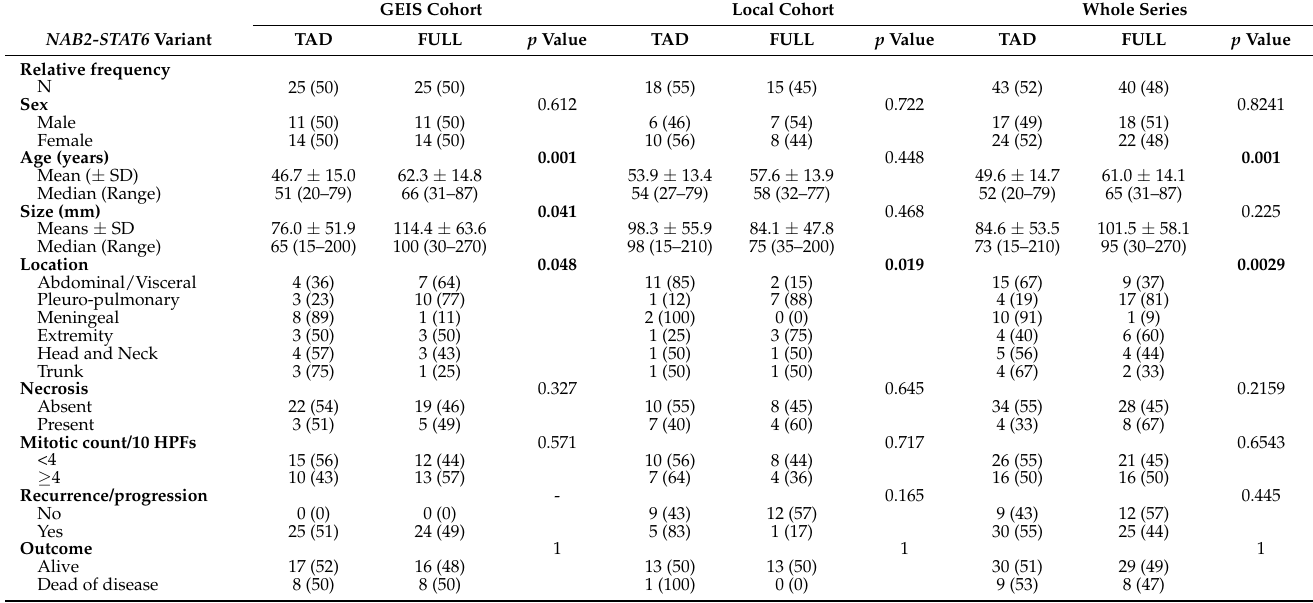
Data are given as number (%) unless otherwise indicated. Significant p values are indicated in